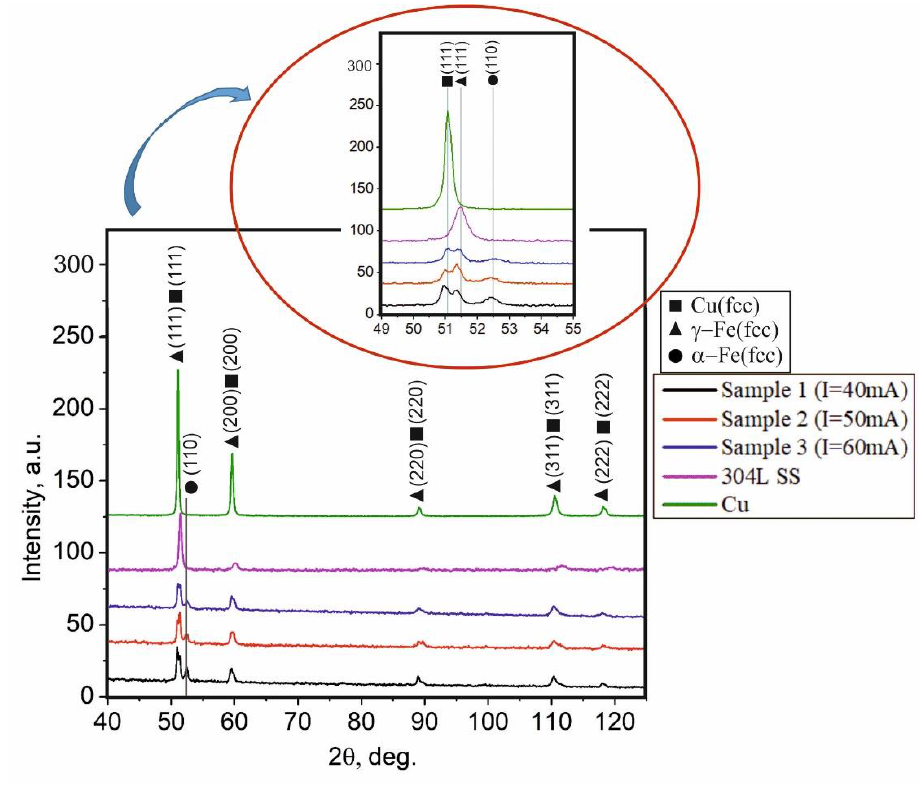
Figure 2. X-ray diffraction patterns of the welded joints and the initial materials. Cross-sectional SEM images of the sample welded by a beam power of 2400 W are shown in Figure 3. The specimen was cut along the z -axis perpendicular to the y -axis. The chemical composition of the obtained joint was studied by using EDX experiments, and the results are presented in Figure 3d and Table 1. A detailed SEM image with a higher magnification (Figure 3b) of the interface between the fusion zone (FZ) and the stainless steel (SS) exhibits a narrow area of a solid solution between the Fe and Cu as well as undissolved Cu particles. Moreover, a wide area of molten copper can be observed within the fusion zone. This means that the joint consisted almost entirely of copper and a very small amount of SS. This could be attributed to the relatively low beam power, which was not high enough for the melting of the steel [29]. The SEM image presented in Figure 3c shows the structure of the copper after the welding process, in which a large number of pores are observable. The aforementioned attribution was confirmed by using the EDX experiments, in which it was shown that the amount of copper within the fusion zone remained relatively unchanged in comparison with that in the welded Cu plate. The measured average grain size within the welded joint was 1.640 ± 0.438 μm.